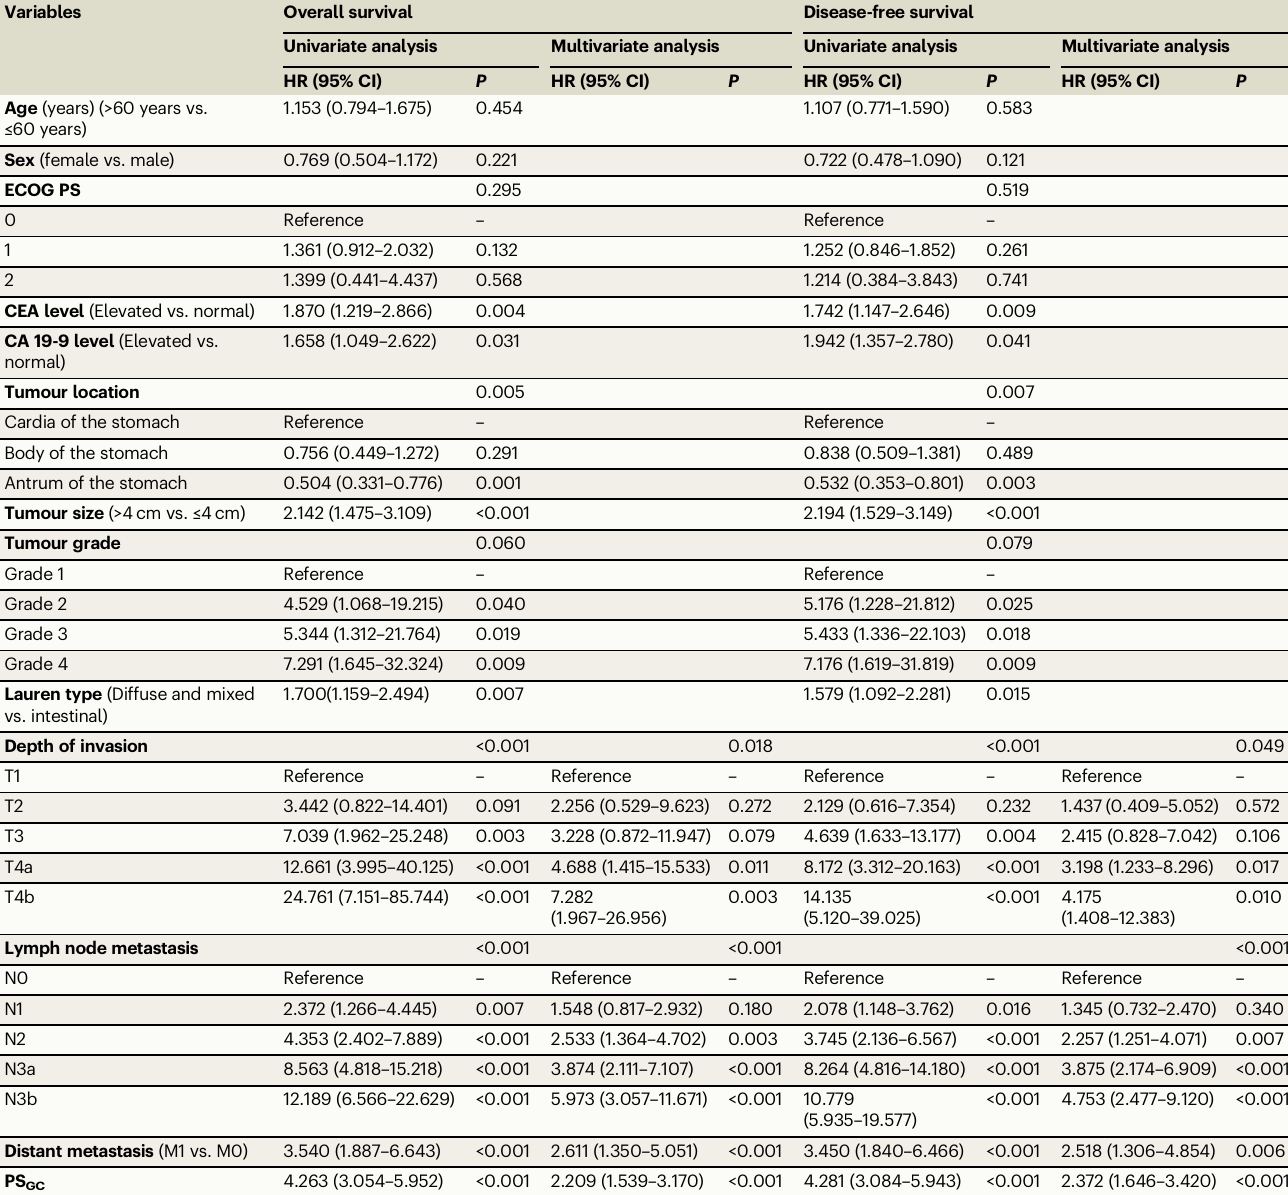
Table 2 | Univariate and multivariate Cox regression analyses of the PS GC and clinicopathological characteristics for overall survival and disease-free survival in training cohort